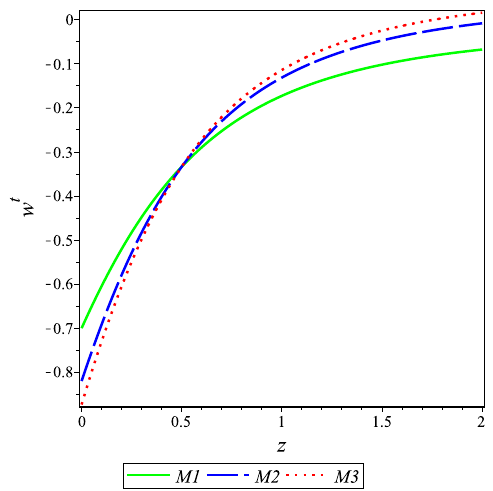
Figure 4. The The equation of state (EoS) parameter, w t (42), versus redshift, z , for three observational models M1, M2, and M3. See text for